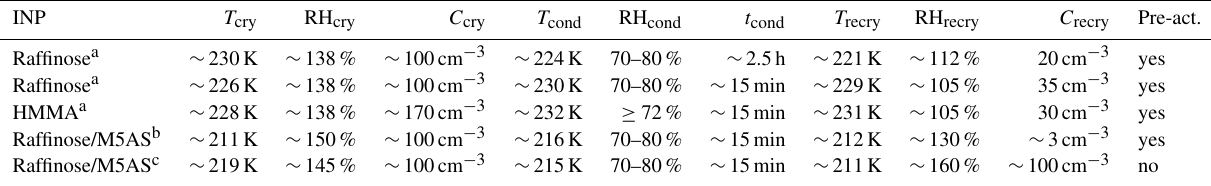
Table 9. AIDA chamber experiments by Wagner et al. (2012). T cry – crystallization temperature; RH cry – crystallization RH with respect to ice; C cry – ice crystal concentration during the first expansion run; T cond – conditioning temperature with respect to ice; RH cond – conditioning RH with respect to ice; t cond – conditioning time; T recry – recrystallization temperature; RH recry – recrystallization RH with respect to ice; C recry – ice crystal concentration during the second expansion run. INP T cry RH cry C cry T cond RH